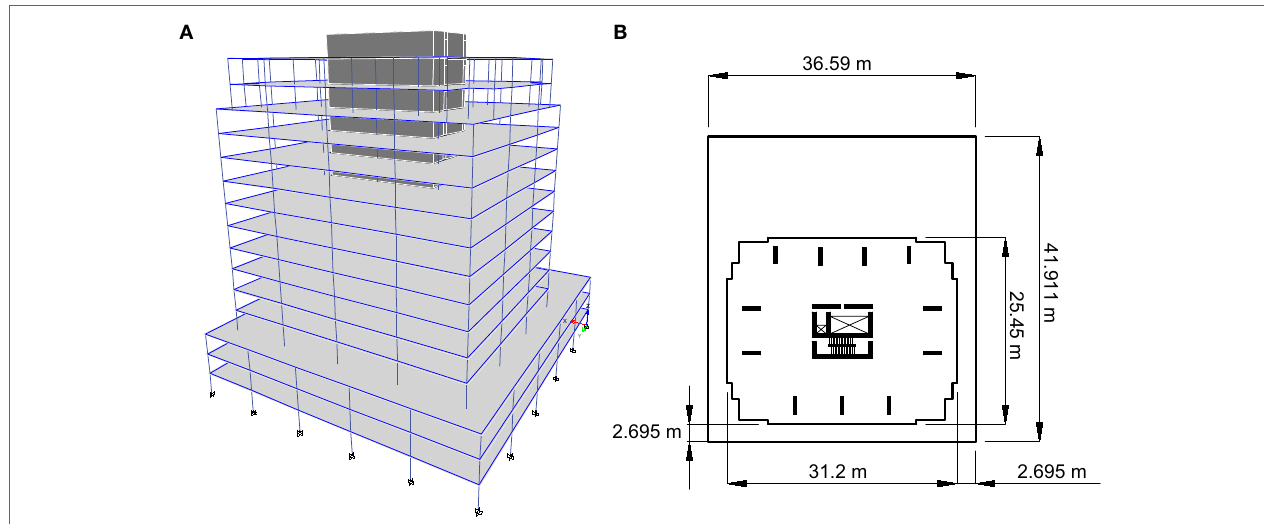
FIGURE 2 | (A) Schematic view of the Heritage Court Tower building. (B) Schematic of a typical floor plan.